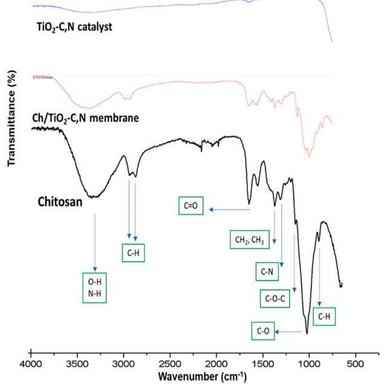
FT-IR transmittance spectra of chitosan, TiO2–C,N powder, and Ch/ TiO2–C,N membrane.